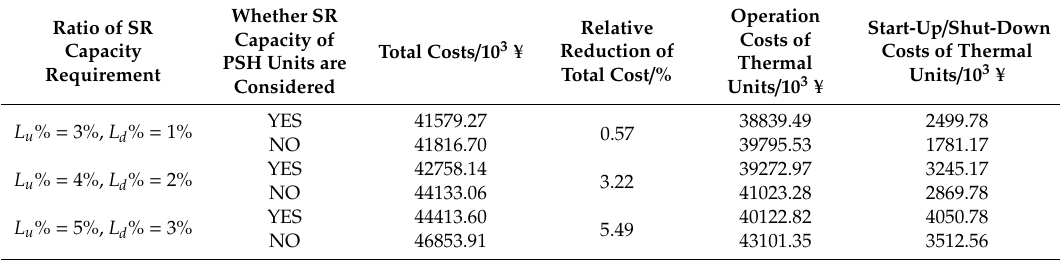
Table 14. ComparisonoftheresultswhenthePSHunits’spinningreserveisconsideredornotconsidered. Ratio of SR Capacity